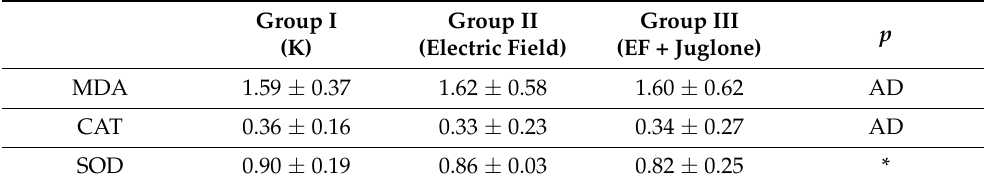
Table 6. Oxidant and antioxidant levels of research groups. Group I